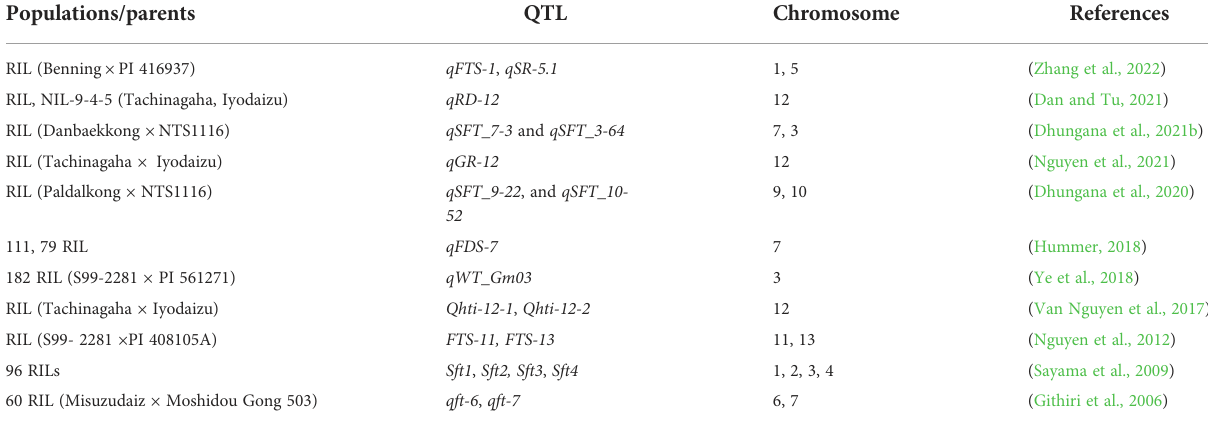
TABLE 1 QTL identi fi ed for fl ood tolerance in